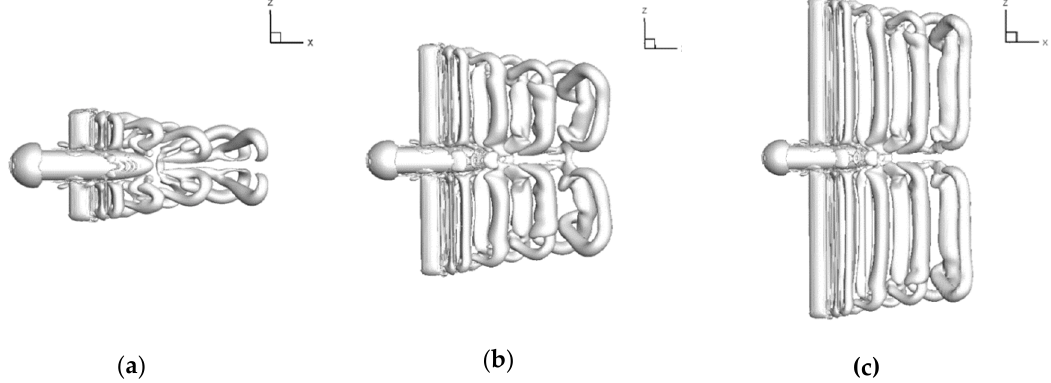
Figure 7. Side view of the vortex structures for three typical AR values ( a ) AR = 1.0; ( b ) AR = 1.0; and ( c ) AR = 5.0. Figure 8. View of vortex structures for three typical AR values ( a ) AR = 1.0; ( b ) AR = 1.0; and ( c ) AR = 5.0.